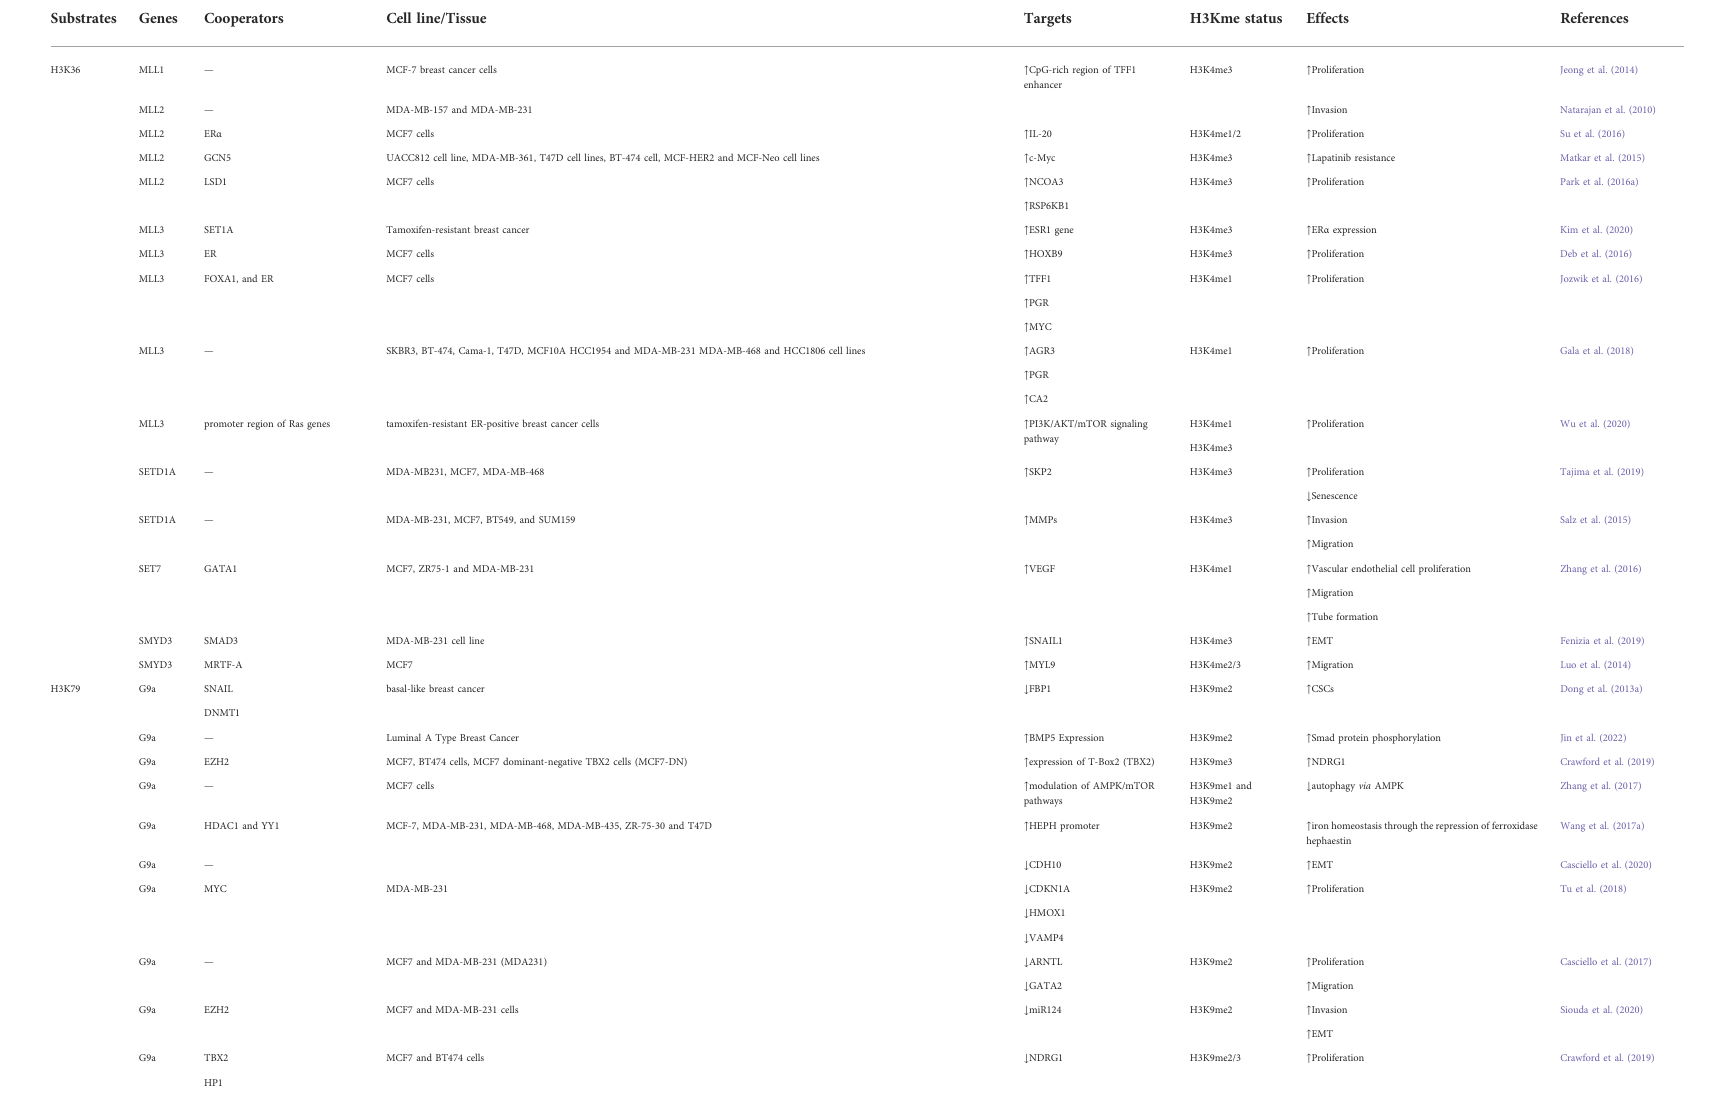
TABLE 1 Status of histone methylation marks studied in breast cancer subtypes. Substrates